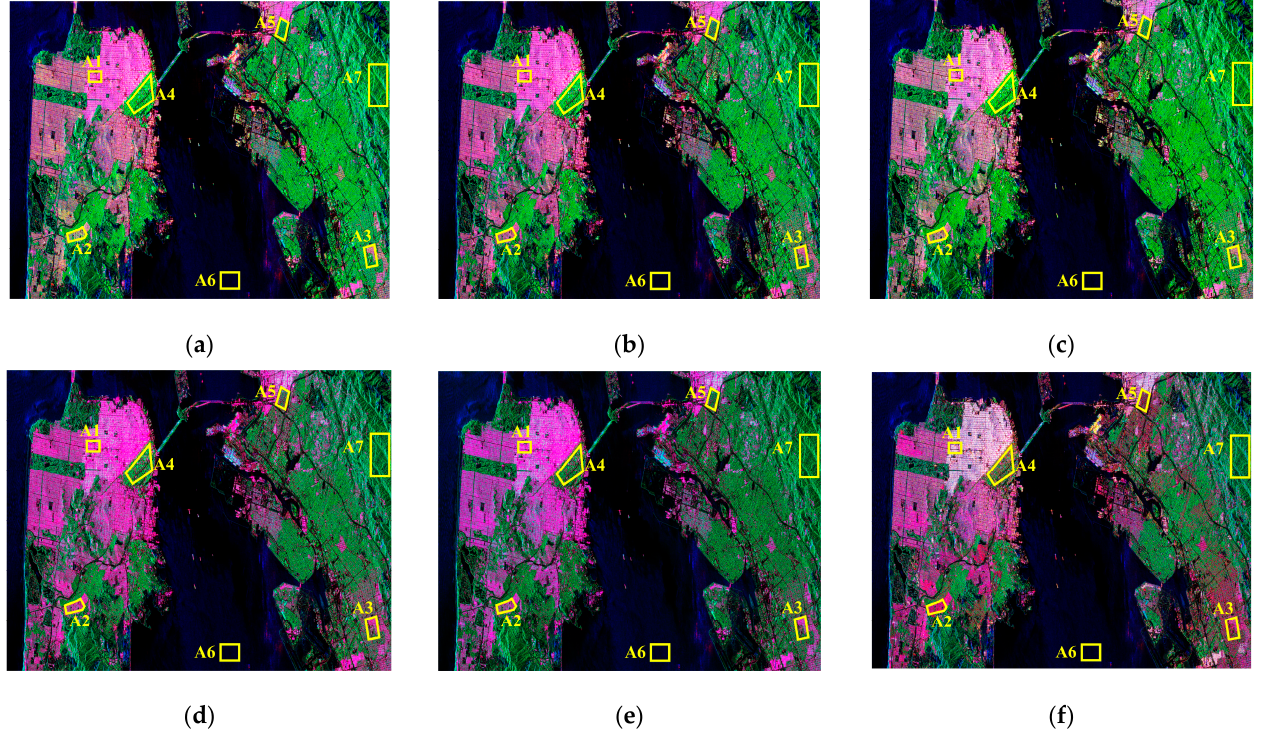
Figure 9. Decomposition results of ALOS-2/PALSAR-2 data sets over San Francisco (RGB component: red: double-bounce scattering, green: volume scattering, blue: surface scattering). ( a ) Y4O, ( b ) Y4R, ( c ) G4U, ( d ) 6SD, ( e ) 7SD, ( f )